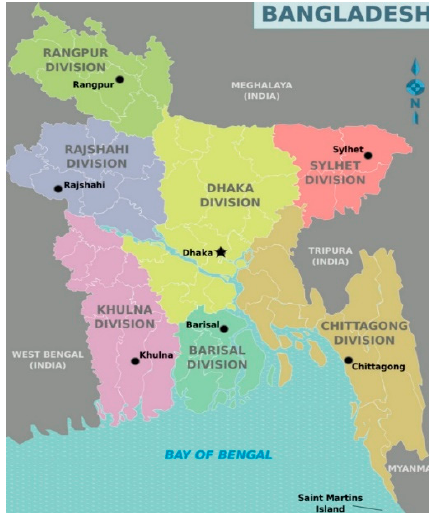
Figure 1. A map of Bangladesh showing seven administrative divisions [21].